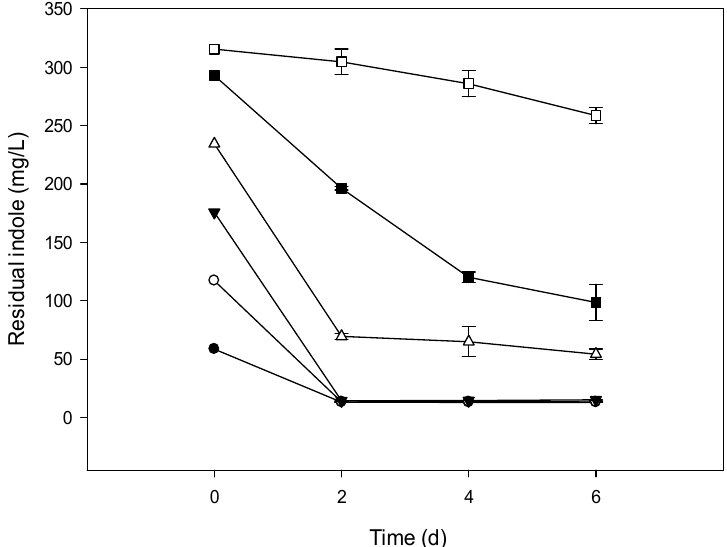
Figure 1. Indole removal capability of NTA1-2A strain at different initial concentrations (mg/L). Symbols: Solid circle, 58.58; open circle, 117.15; solid triangle, 175.73; open triangle, 234.30; solid square, 292.87; open square, 351.45; error bars, mean ± Standard Error (SE) of three replicates at 31 °C and pH 6.